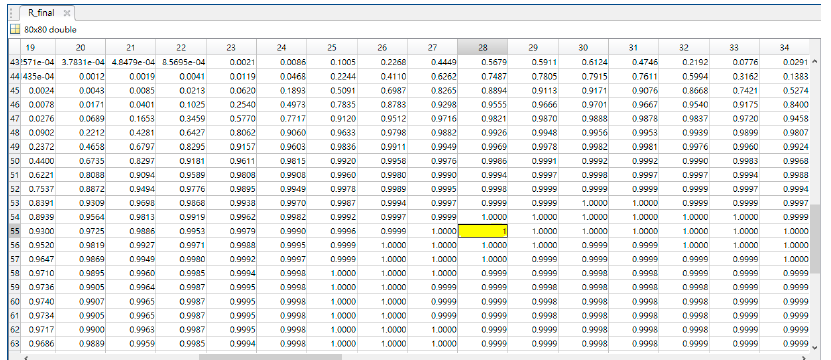
Figure 11. Invariant moment similarity weighting matrix.